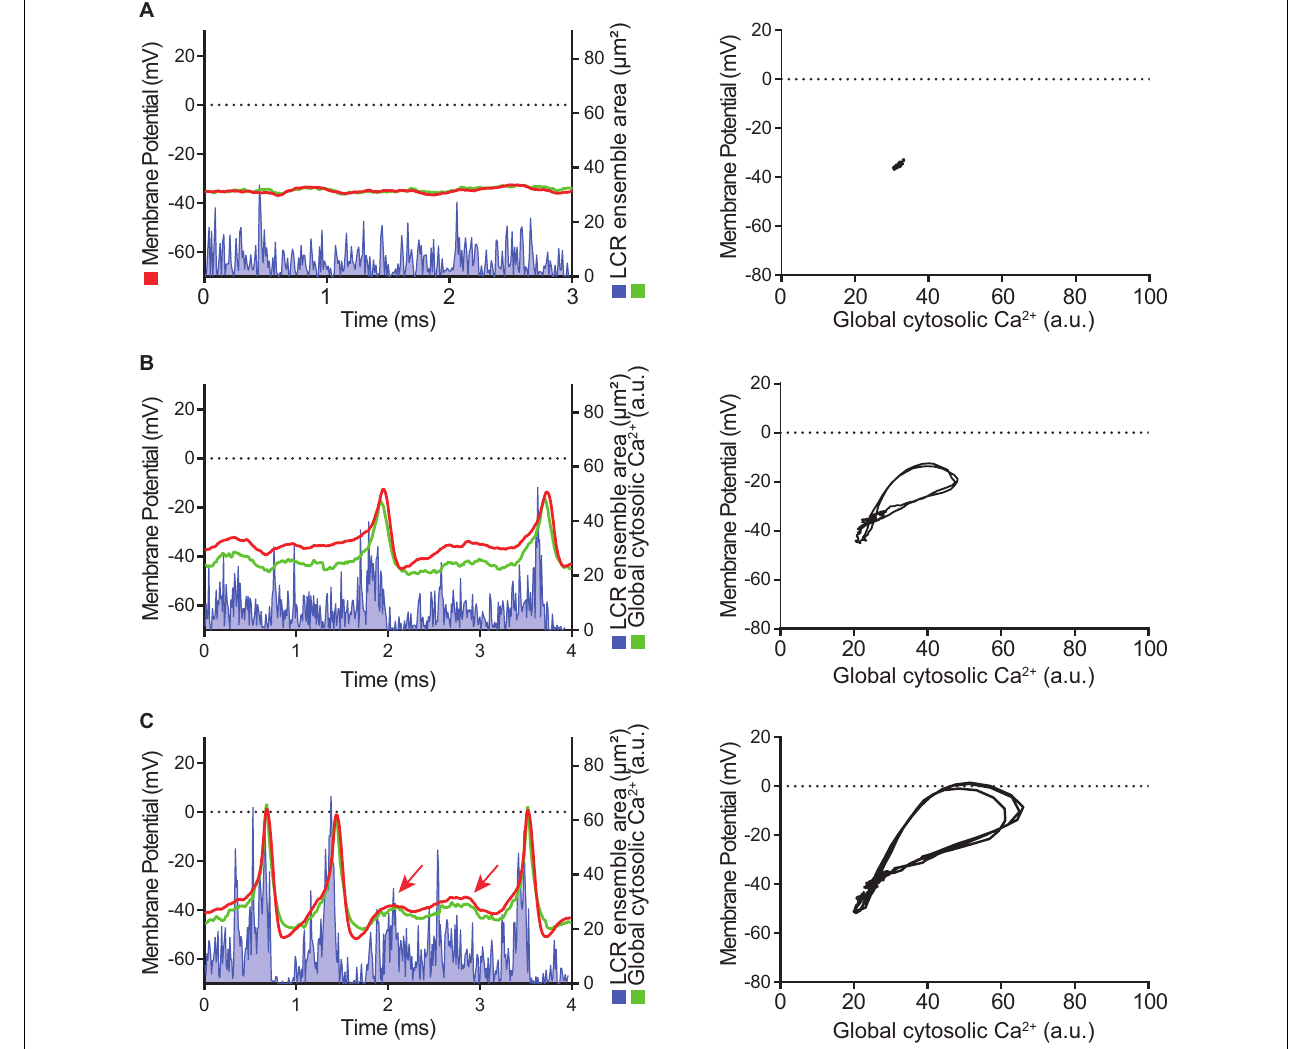
FIGURE 4 | Time domain (left column) and the Ca 2 + -voltage phase-plot loops (right column) of simultaneous membrane potential (red), whole-cell Ca 2 + transient (green) and LCR ensemble area (blue) measurement at the early stage of AP induction in response to β -AR stimulation in a SANC that was electrically dormant at baseline. Note that, to minimize both phototoxicity and bleaching of the Ca 2 + indicator, Ca 2 + signals could be recorded only for short time window, although membrane potential could be recorded for prolonged periods: (A) Baseline, (B) The first AP, and (C) Following early phase that is characterized by APs with a small amplitude and failed ignition (arrows). Blue line shows the integrated area of detected individual LCRs by our image analysis program (Maltsev et al., 2017).